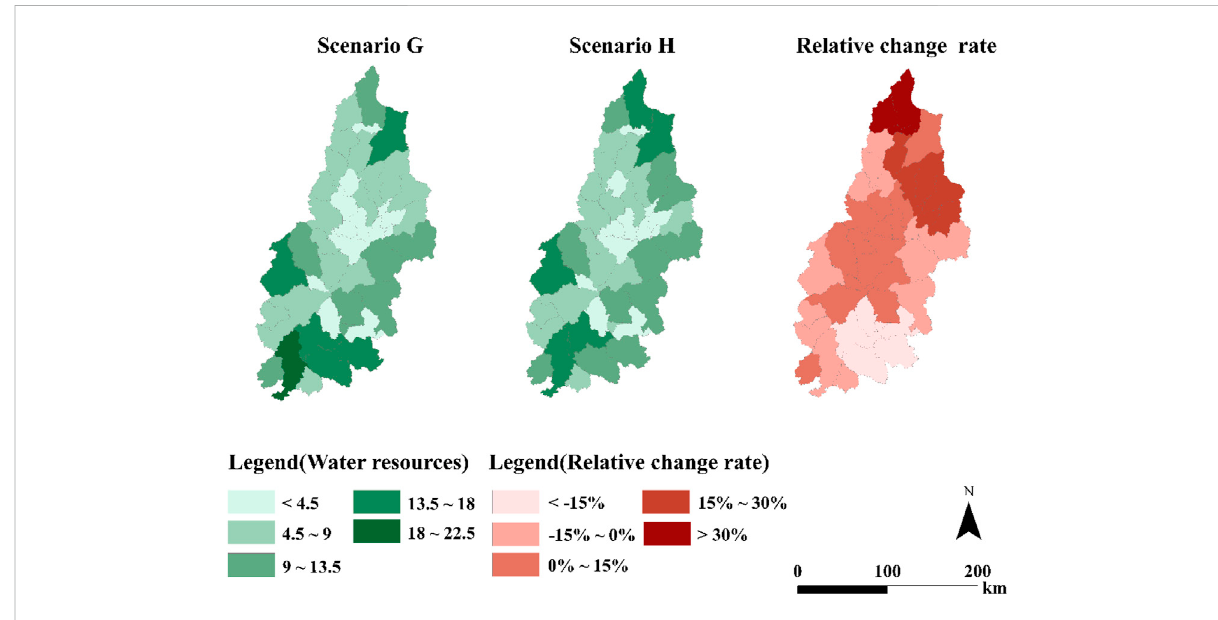
FIGURE 7 Changes in water resource at the sub-basin scale under the in fl uence of combined